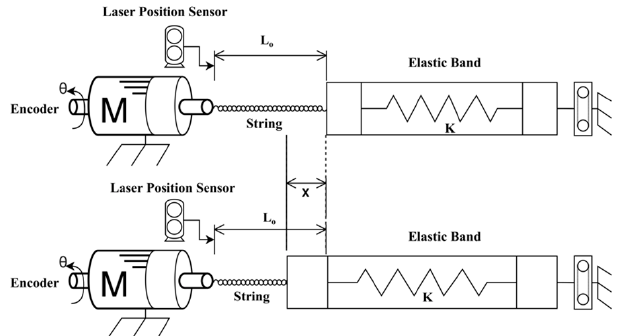
Figure 4. Helix’s geometry model for TSA.